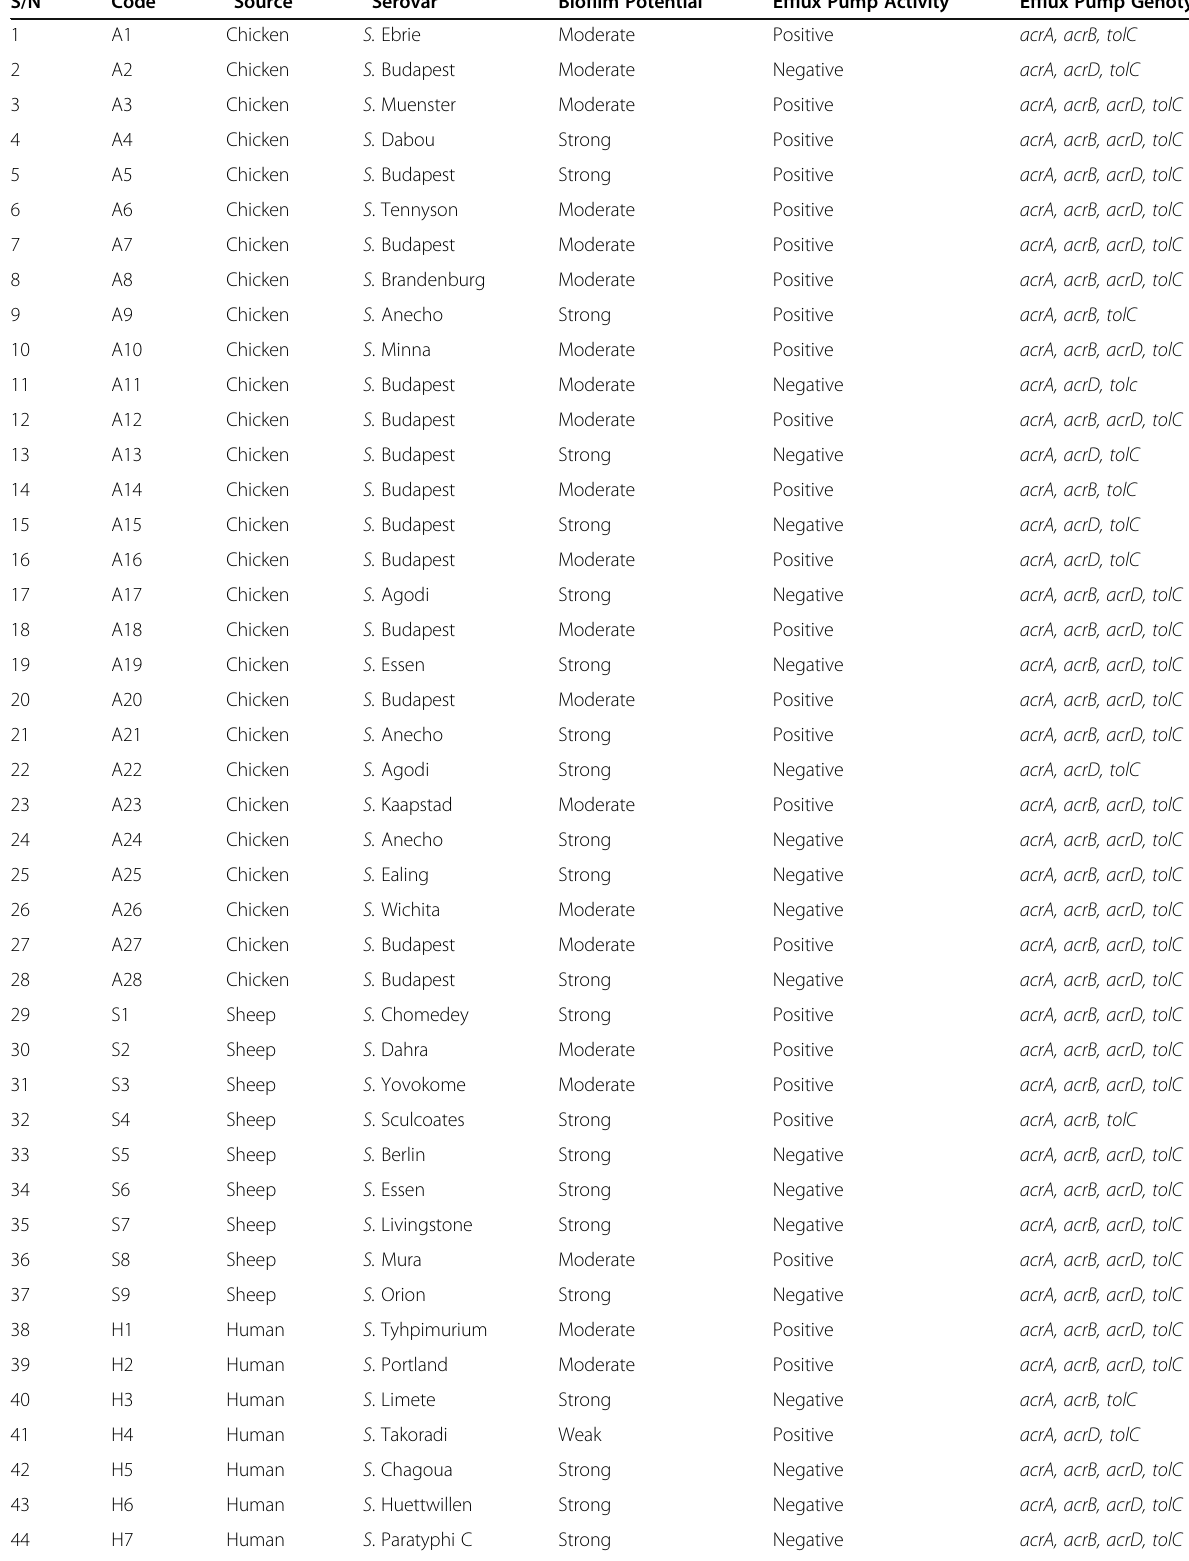
Table 3 Source of Salmonella Serovars, their Biofilm Forming Potential, Efflux Pump Activity and Efflux Pump Genotype